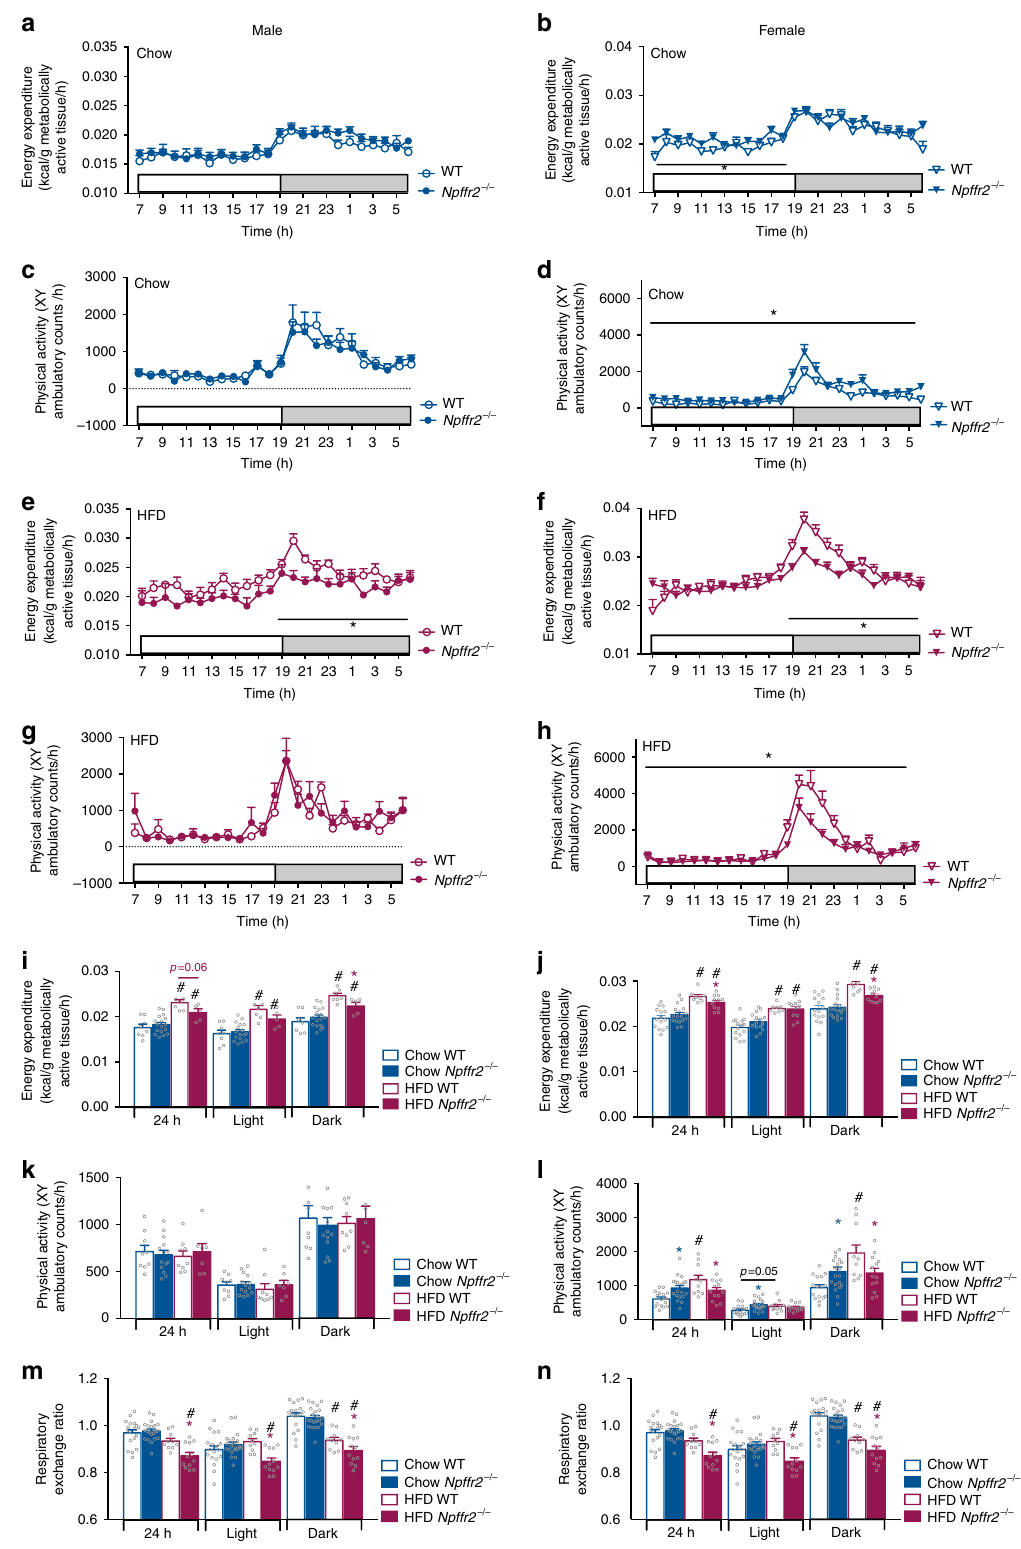
Fig. 3 Energy homoeostasis parameters in WT and Npffr2 − / − mice under chow and HFD conditions. a – d Time-course of energy expenditure ( a , b ) and physical activity ( c , d ) in WT (open circle) and Npffr2 − / − ( fi lled circle) mice of both genders on chow. e – h Time-course of energy expenditure ( e , f ) and physical activity ( g , h ) in WT and Npffr2 − / − mice of both genders on HFD. i – n Energy expenditure ( i , j ), physical activity ( k , l ) and respiratory exchange ratio ( m , n ) averaged over 24h in WT and Npffr2 − / − mice fed on chow or HFD. Male chow: WT n = 8, Npffr2 − / − n = 14; male HFD: WT n = 9, Npffr2 − / − n = 7. Female chow: WT n = 14, Npffr2 − / − n = 17; female HFD: WT n = 8, Npffr2 − / − n = 11. Data are mean±SEM. One-way ANOVA ( i – n ) or repeated measures ( a – h ) were used to determine genotype or diet effects among groups. ∗ p <0.05 vs. WT of the same diet. # p <0.05 vs. chow group of the same